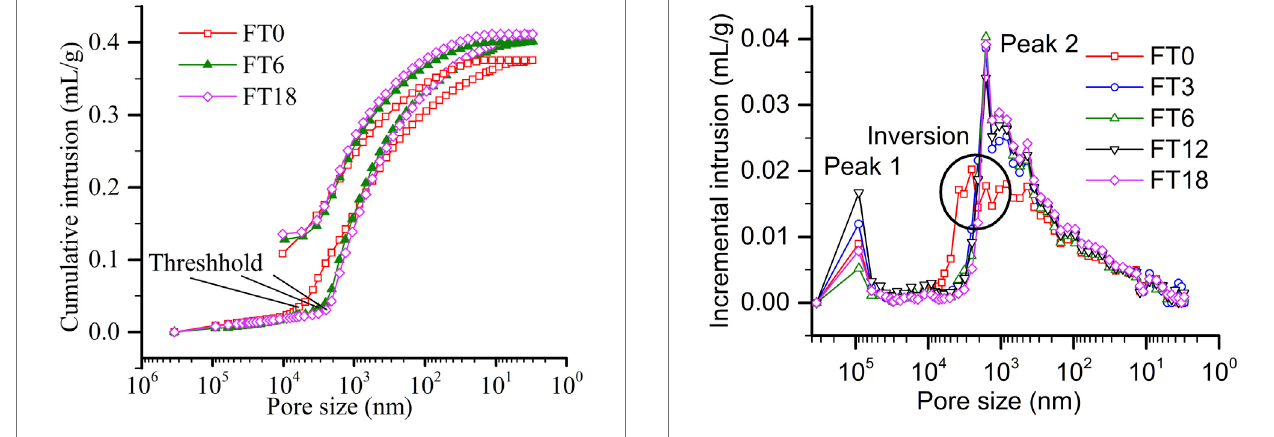
FIGURE8| Cumulativeintrusioncurves ofS/SsedimentsinFTsbyMIP. FIGURE9| IncrementalintrusioncurvesofS/SsedimentsinFTsbyMIP.